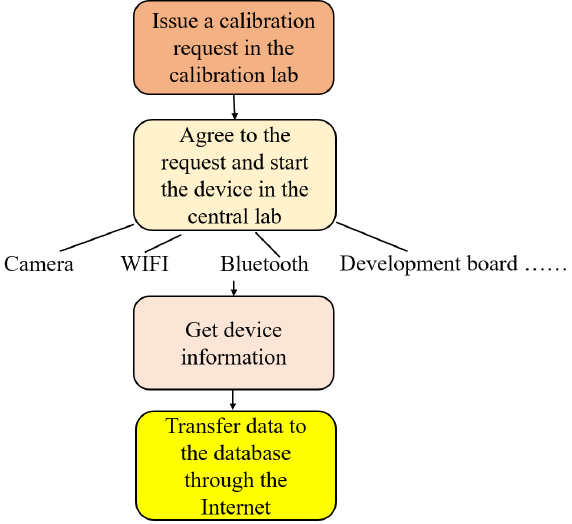
Figure 3. Step of remote